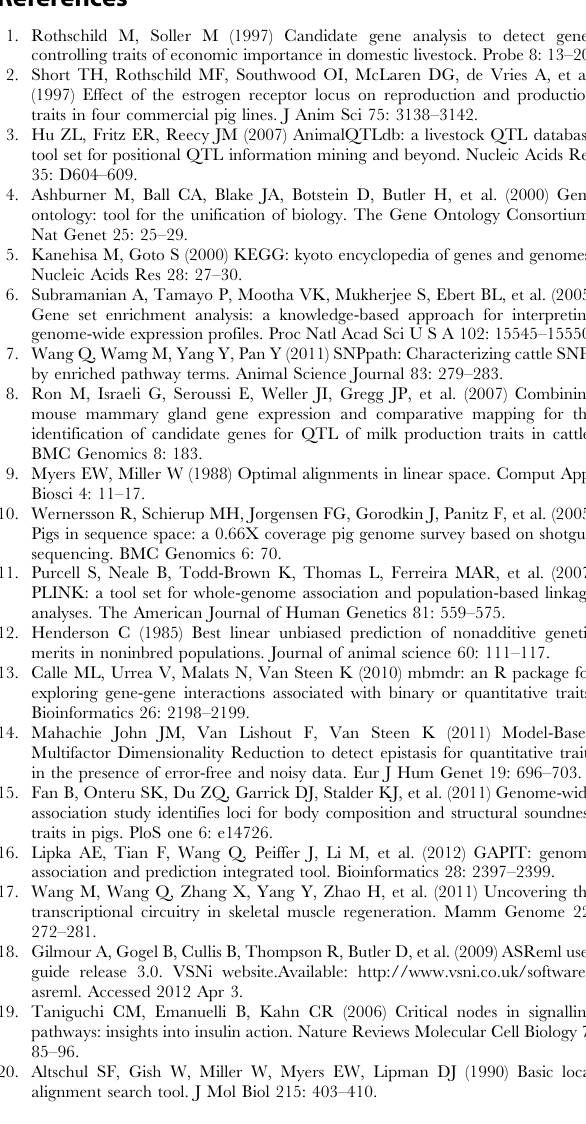
Table S5 The genes from the IGF1/FoxO signal trans- duction pathway identified as being co-localized with published QTL from